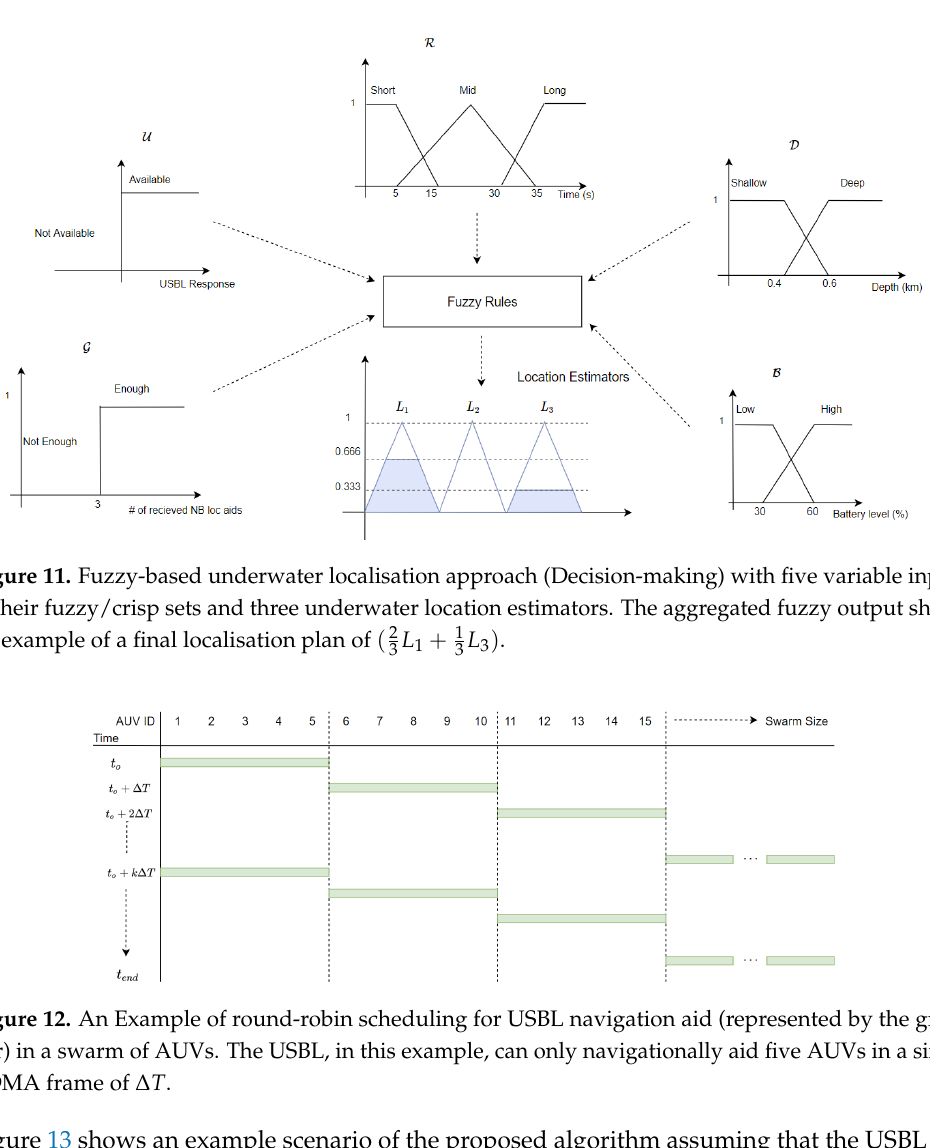
Figure 12. An Example of round-robin scheduling for USBL navigation aid (represented by the green bar) in a swarm of AUVs. The USBL, in this example, can only navigationally aid five AUVs in a single TDMA frame of ∆ T